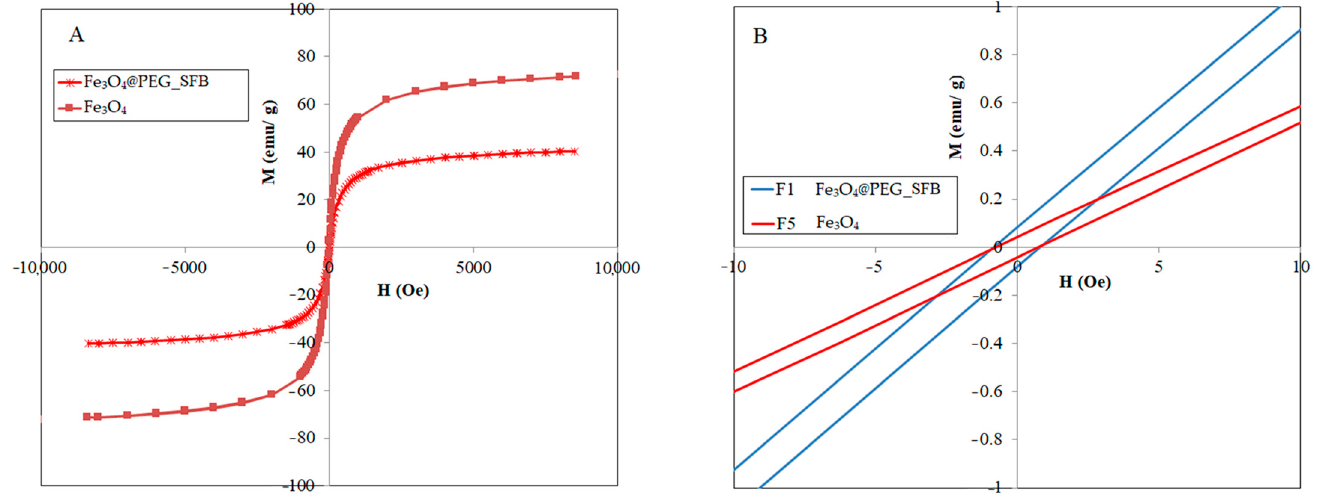
Figure 3. ( A ) Magnetic properties; ( B ) Hysteresis curve in fields close to zero of synthesized Fe 3 O 4 particles and Fe 3 O 4 @ − PEG_SFB nanocomposite.